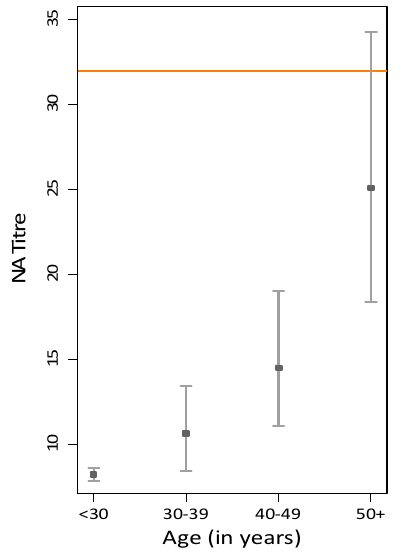
Figure 1. Plot of anti-vaccinia neutralising antibody titre by age, for total sample ( n = 177) and by sex ( n male = 100, n female = 77).